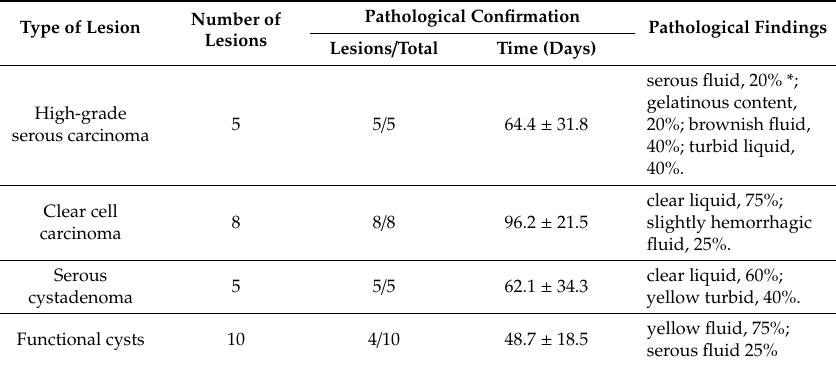
Table 1. Pathological